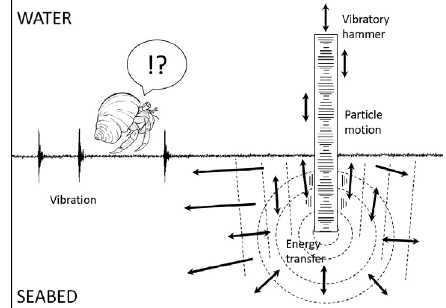
Figure 10: Anthropogenic vibration . Particle- motion disturbance by anthropogenic activities in the seabed. From “Good or bad vibrations? Impacts of anthropogenic vibration on the marine epibenthos” , by Roberts & Elliot, 2017, p.